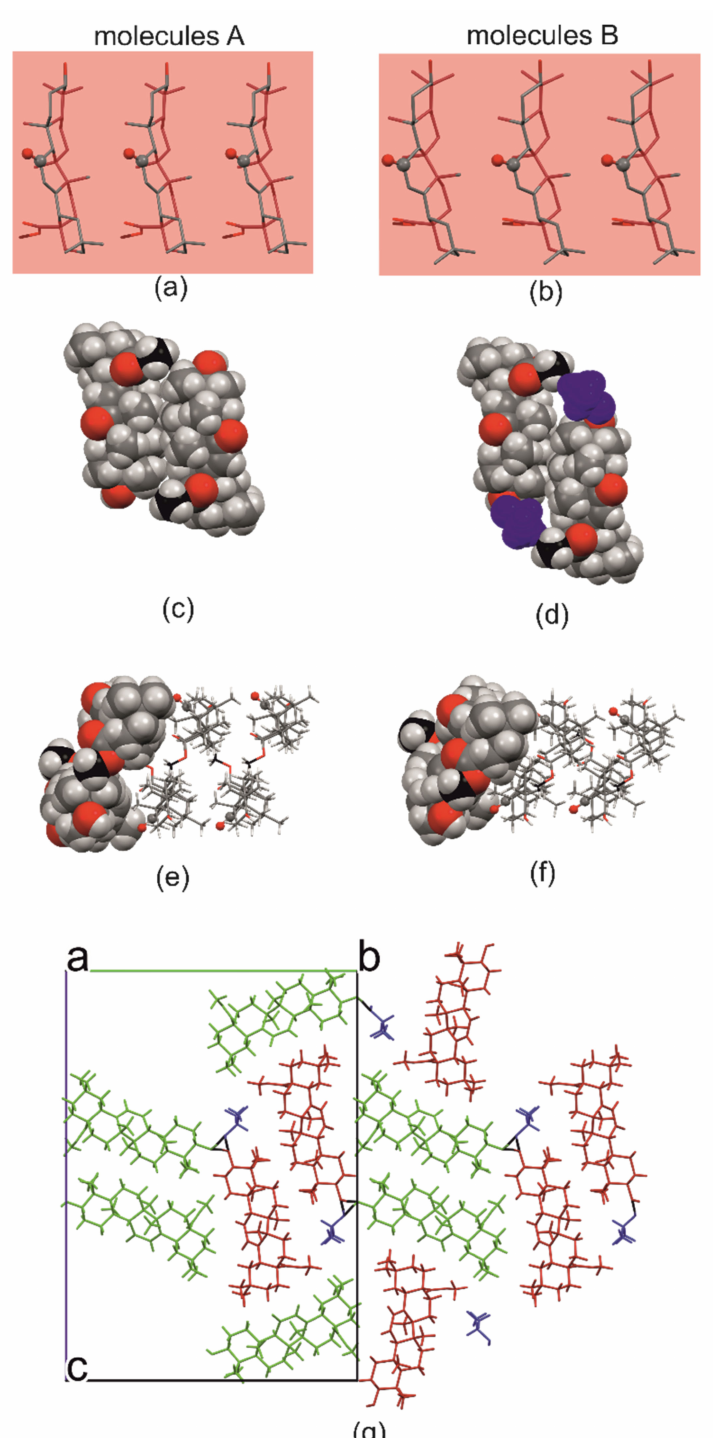
Figure 11. ( a , b ) Rb HH ribbons formed in the 11-oxo-Me-OA : The C11/O11 atoms are shown as balls; the ribbons’ plane is shown in light red; H atoms are omitted for clarity. Dimer shown along ribbons’ direction ( c , d ) and triterpene long axis ( e , f ). The methyl substituents are colored in black and 2-propanol molecules in violet. ( g ) The nearest surroundings of the dimer motif. The O-H ··· O hydrogen bonds are shown as black lines. The molecules A are green, B brown, and 2-propanol dark